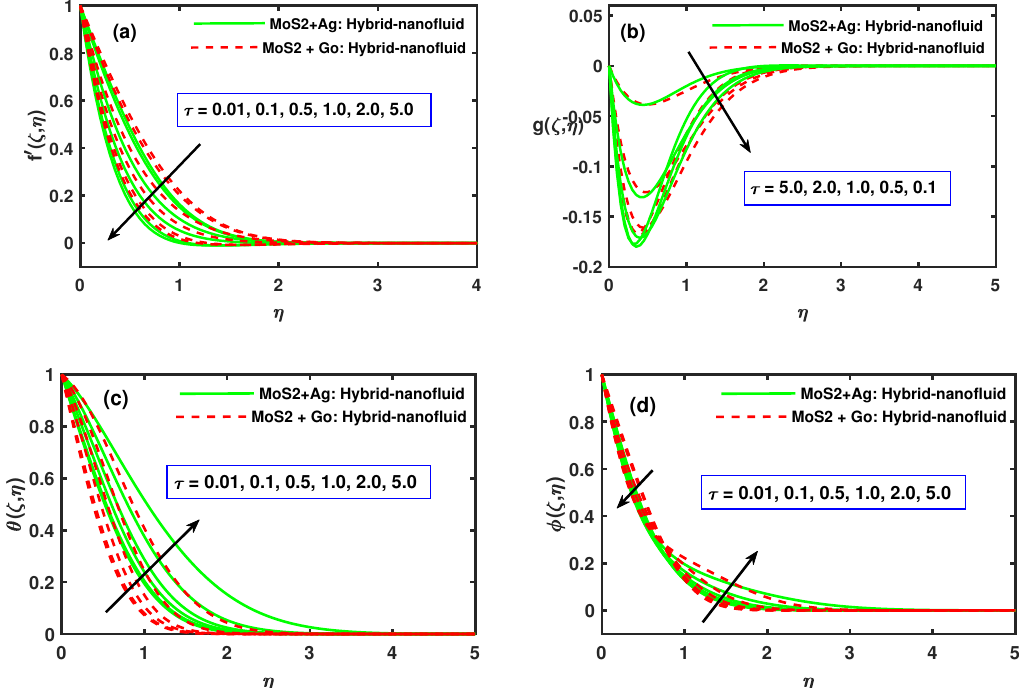
Figure 5. Fluctuation of f (cid:48) ( ζ , η ) , g ( ζ , η ) , θ ( ζ , η ) , and φ ( ζ , η ) along with τ (unsteady parameter) at ζ = 1.